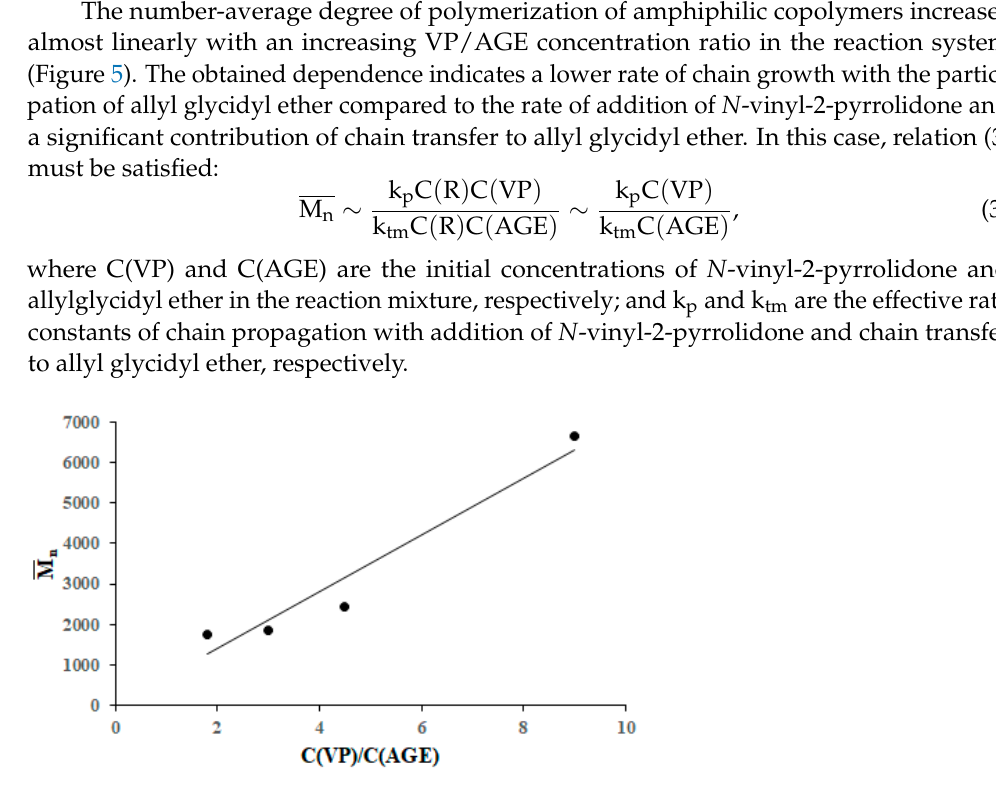
Figure 4. MALDI spectrum of the amphiphilic copolymer of N -vinyl-2-pyrrolidone and allyl glycyl ether acquired under cation registration conditions.